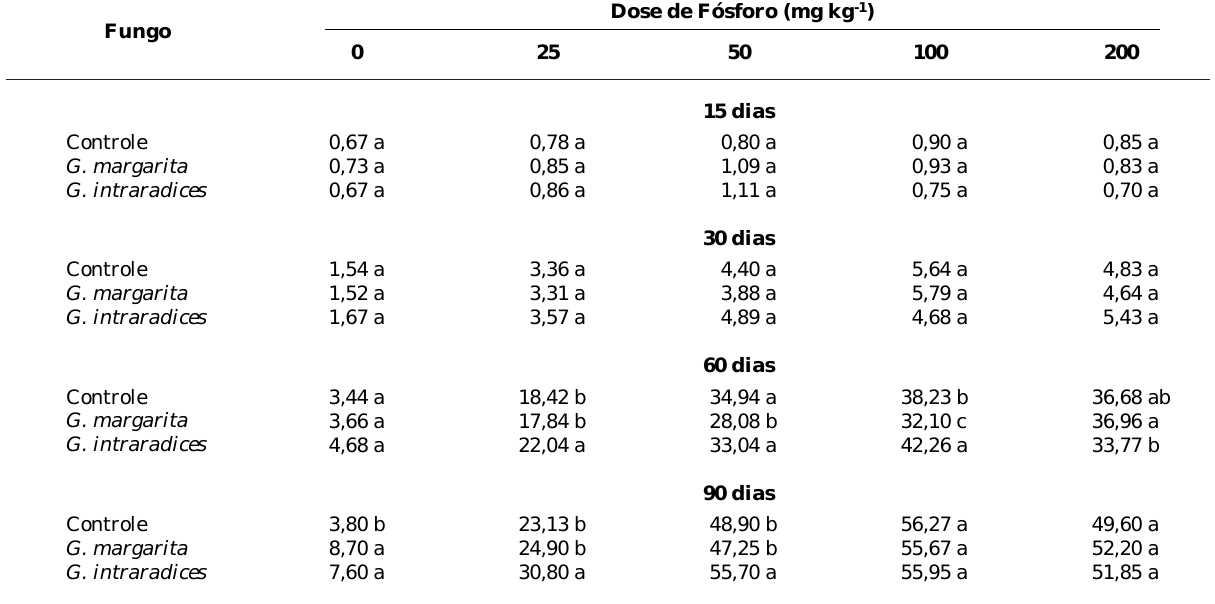
Quadro 1. Produção de matéria seca pela parte aérea de plantas de soja (g vaso -1 ) inoculadas com fungos micorrízicos arbusculares ( G. margarita ou G. intraradices ) ou não inoculadas (Controle), sob